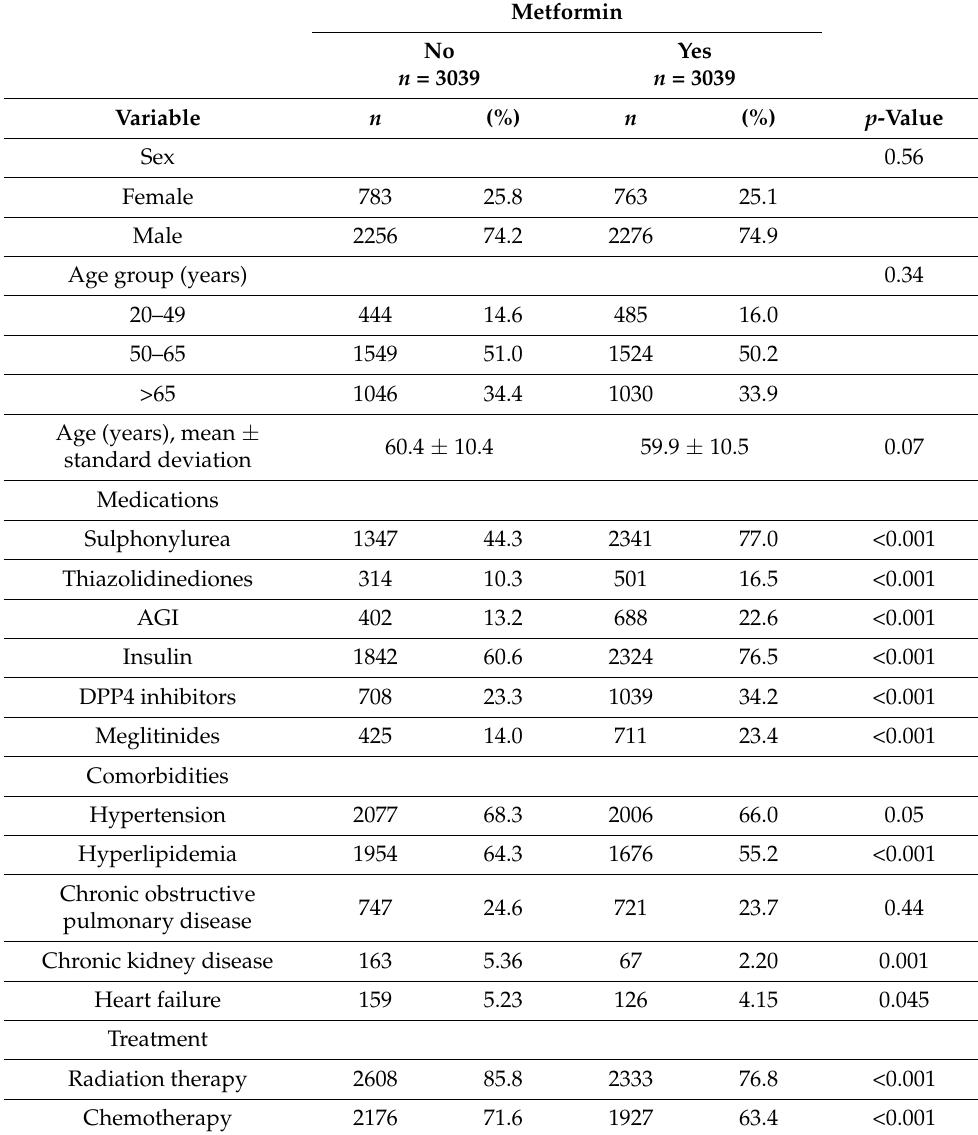
Table 1. Characteristics of nasopharyngeal cancer patients receiving Metformin versus not receiving